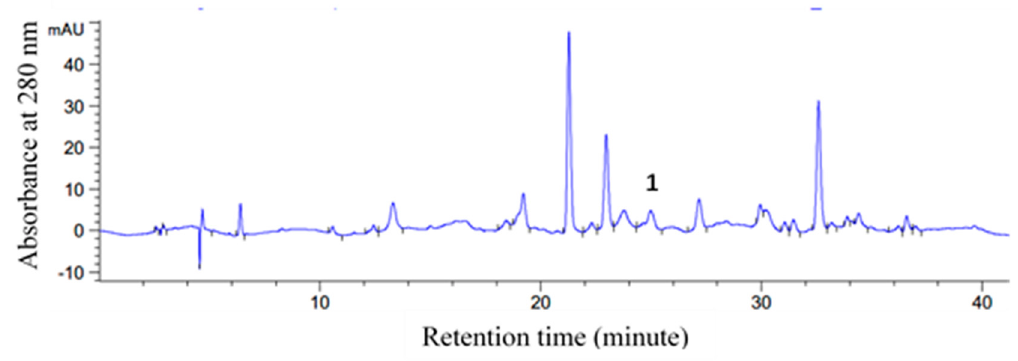
Figure 2. HPLC chromatograms for procyanidin compounds detection ( A ) and flavonoid compounds detection ( B ) in litchi pericarp. Table 1. Changes of phenolic compositions and contents in litchi pericarp stored at 4 °C and at RT (27 ± 2 °C) (mg/g dry weight (DW)). Values with no letters in common in each column are significantly different ( p < 0.05). Values in parentheses indicate decrease percentage to the contents of each individual phenolic in litchi pericarp during storage, respectively.